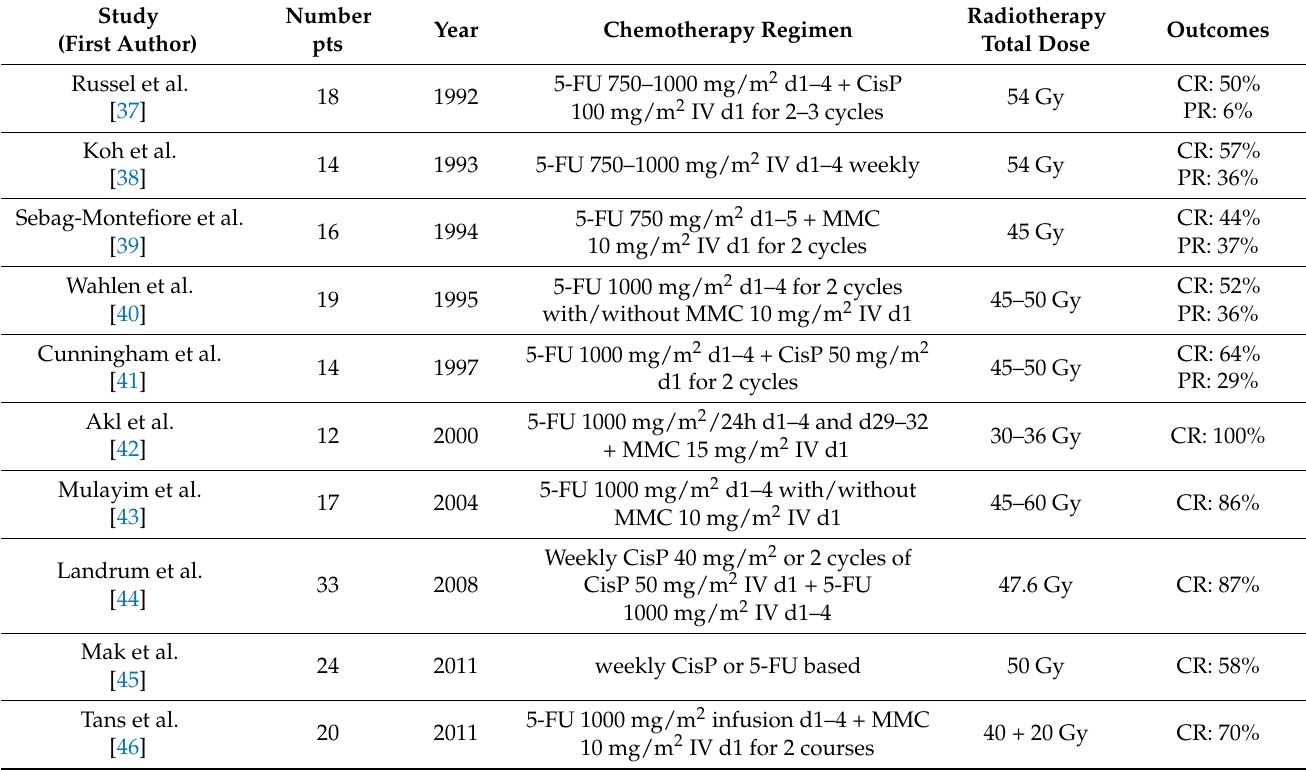
Table 2. Summary of studies with more than 10 patients exploring primary chemoradiation in locally advanced vulvar